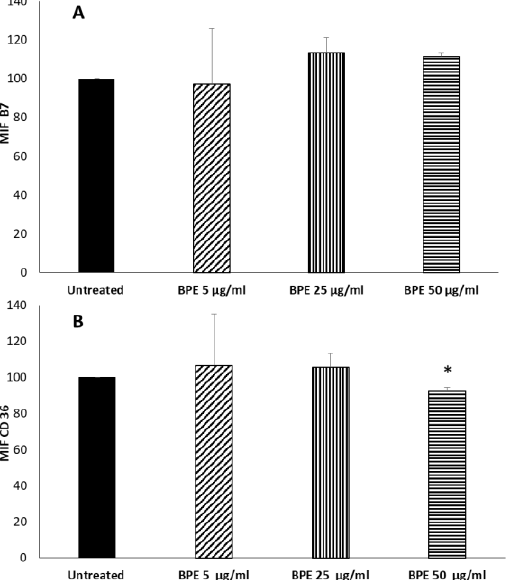
Figure 8. Effect of BPE on macrophages polarization. THP-1-derived macrophages were treated for 24 h with the indicated concentration of BPE. After incubation, cells were labelled with FITC mouse antihuman CD36 ( A ) and PE mouse antihuman B7 ( B ). Labelled cells were analyzed by cytofluorimeter. Results are expressed as Mean Intensity Fluorescence (MIF). The statistical analysis was performed with a two-tailed Student’s t -test. * p < 0.05 (BPE-treated cells vs. untreated cells).